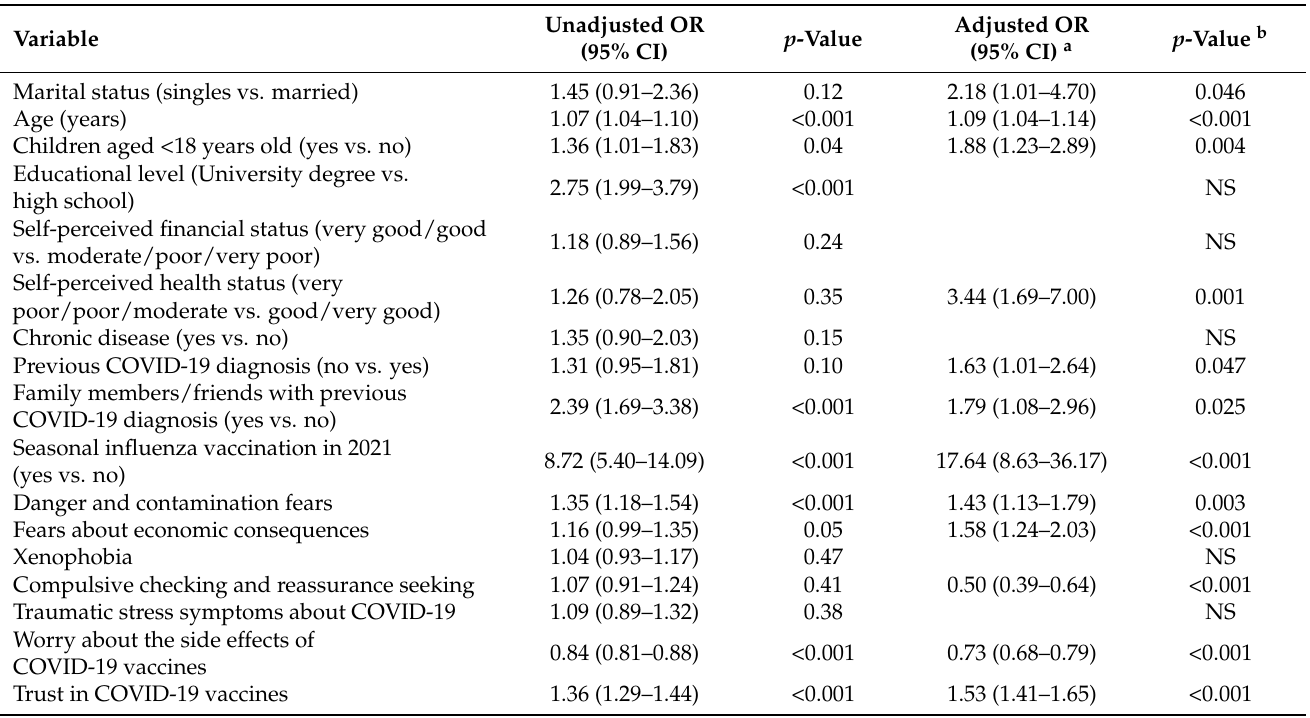
Table 4. Univariate and multivariable logistic regression analysis with COVID-19 vaccine uptake among the pregnant women as the dependent variable (reference: COVID-19 vaccine